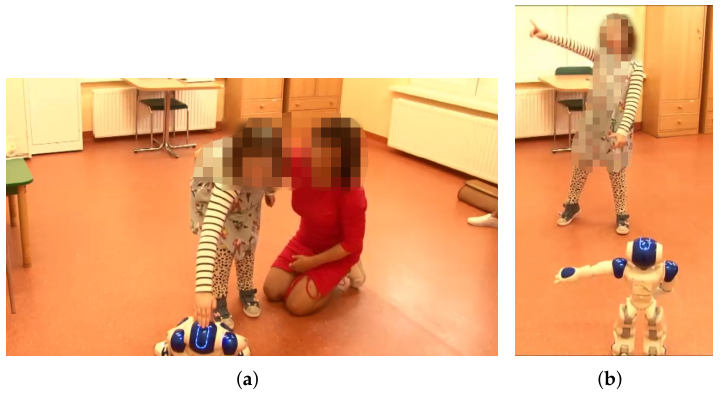
Figure 2. Turn-taking expressed by an autistic child in the Touch me and Dance with me games: ( a ) Touch me , ( b ) Dance with me